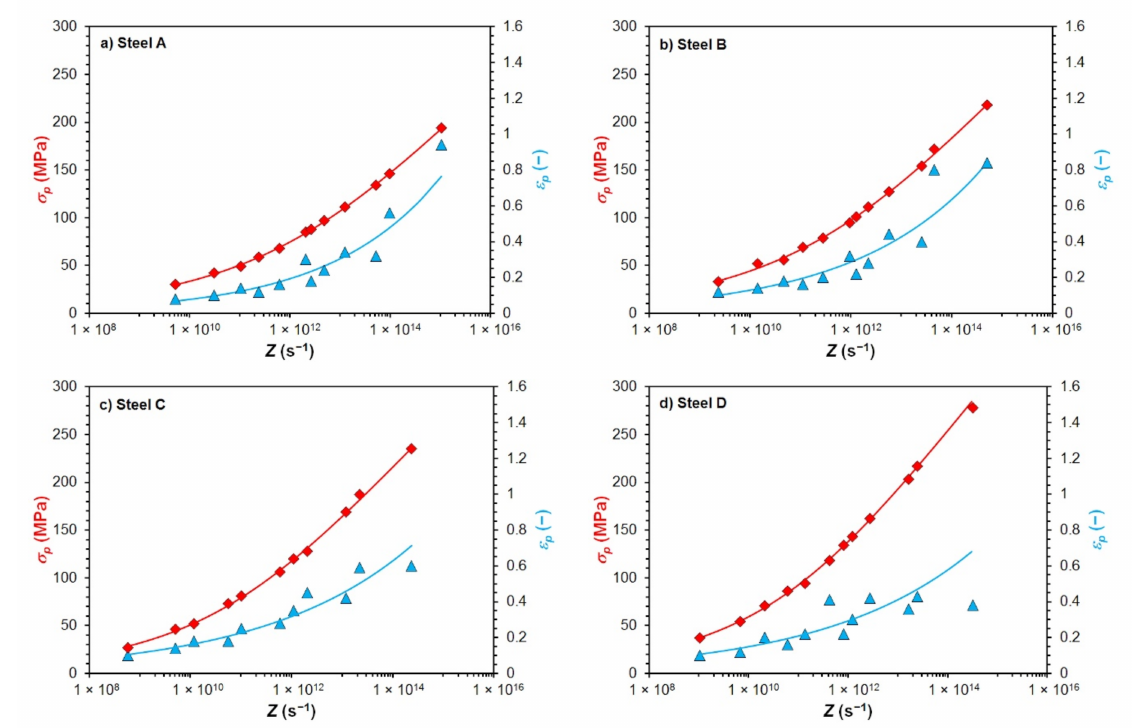
Figure 5. Comparison of measured and predicted values of σ p and ε depending on the parameter Z (points—measured values; lines—predicted values): ( a ) steel A; ( b ) steel B; ( c ) steel C; ( d ) steel